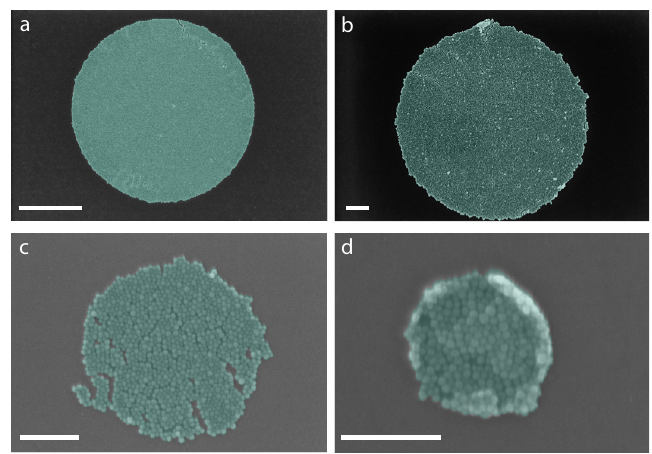
Figure 12. Nanoparticle circles by mask fabrication. Scale bar for ( a ) is 2 µ m. Scale bar for ( b – d ) is 200 nm.